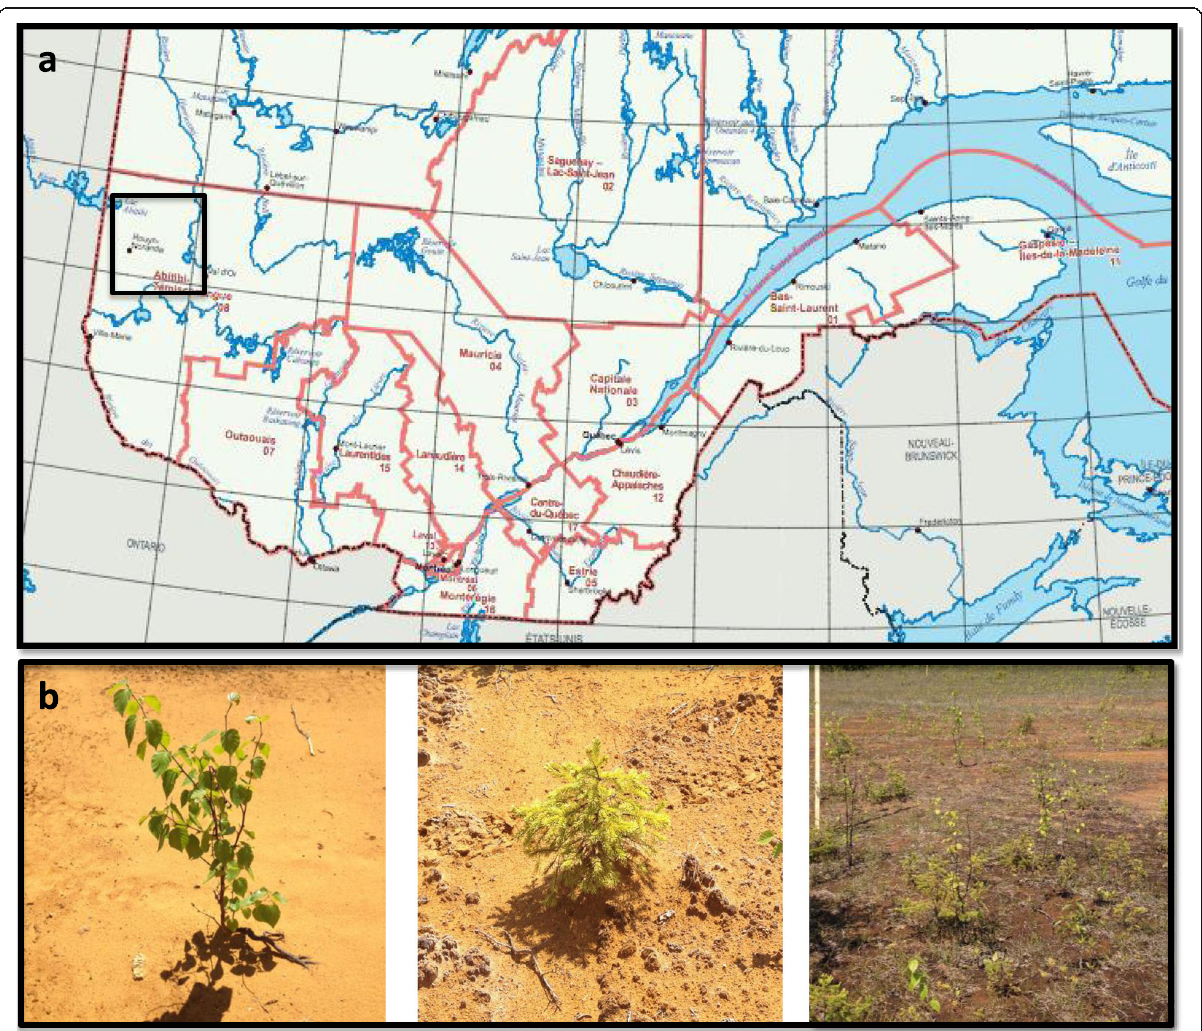
Fig. 1 a Maps of meridional Québec with mine site region (black box) (Ministère de l'Énergie et des Ressources Naturelles (MERN), 2013). b Alder, spruce, birch, and mix of species on the mine